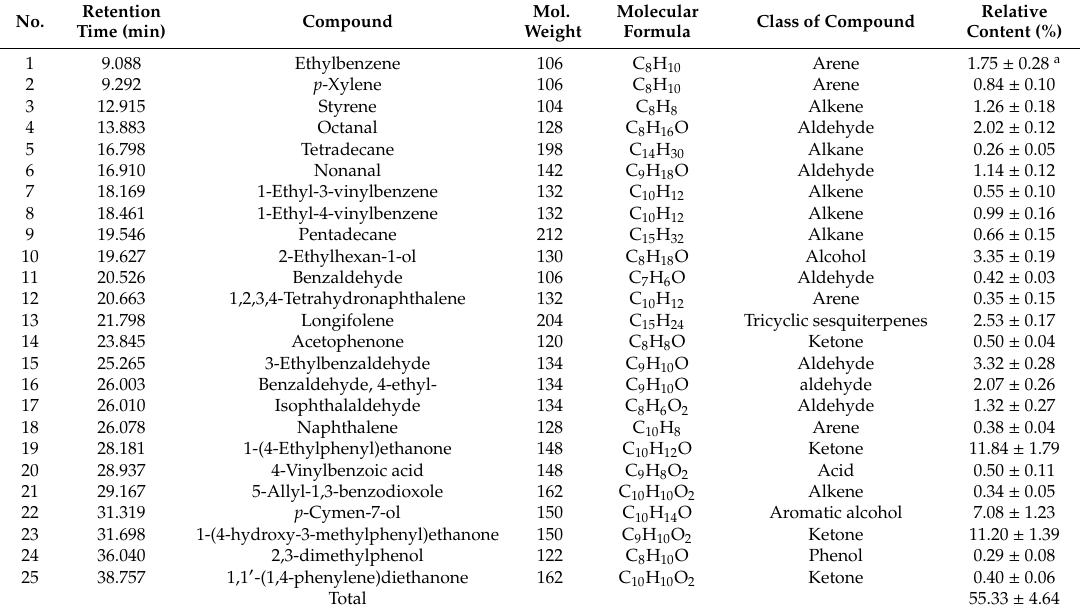
Table 2. Volatile components of the branches of R. potaninii